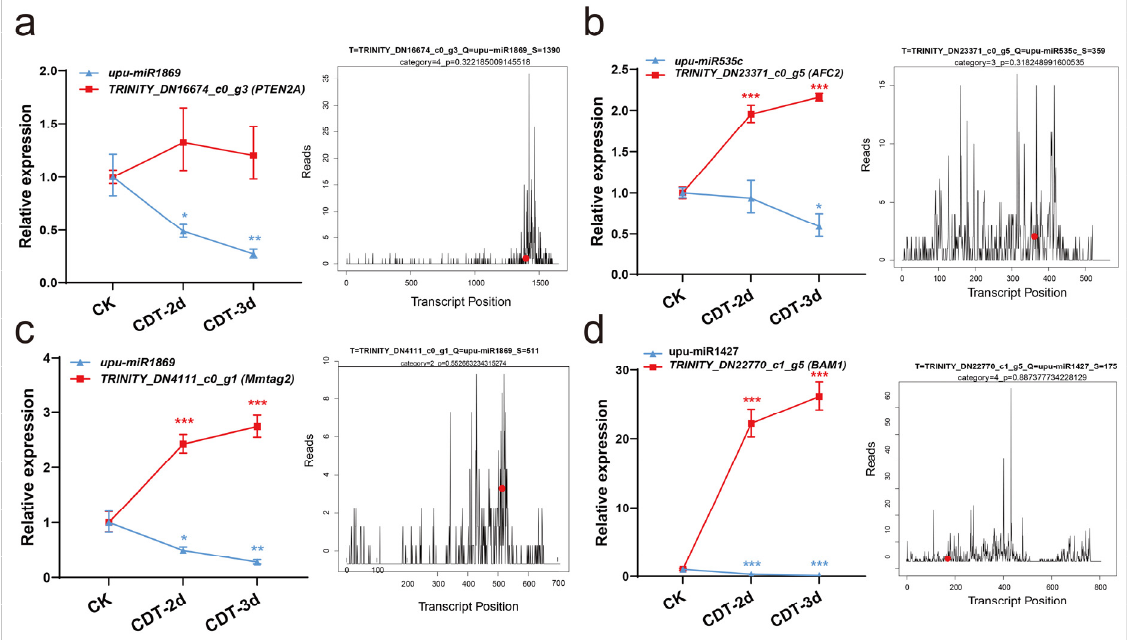
Figure 5. The validation of miRNA cleavage predicted target genes by qRT − PCR. CK, control check; CDT − 2d, seeds aged for two days; CDT − 3d, seeds aged for three days. ( a – d ) MiRNA − target genes confirmed by qRT − PCR (left panel) and target plots (t − plots) of degradome sequencing (right panel). The T − plots diagram shows the full − length distribution of the degradome tags along the target gene sequence. The vertical line with red point indicates the cleavage site of each transcript. Error bars indicate the standard deviation of three replicates. *, p < 0.05; **, p < 0.01; ***, p < 0.001.